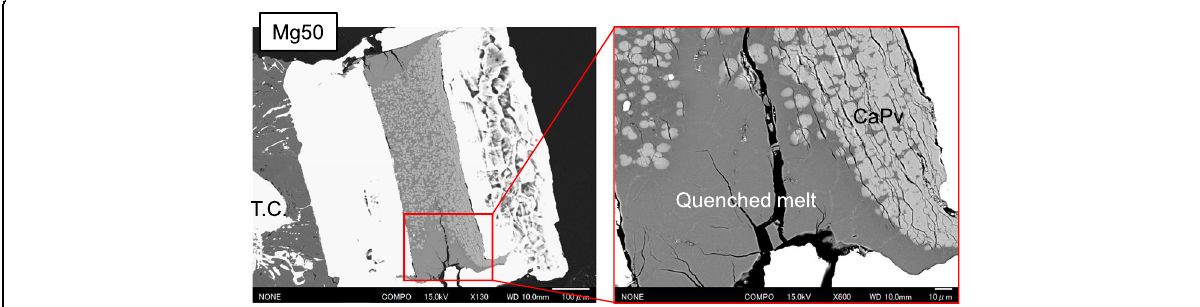
Fig. 6 Backscattered electron images for the sample recovered from high pressure and high temperature (Run No. OS3150-Mg50). A quenched melt was found at the hottest region surrounded by CaSiO 3 -rich perovskite (CaPv), which is interpreted as the liquidus phase